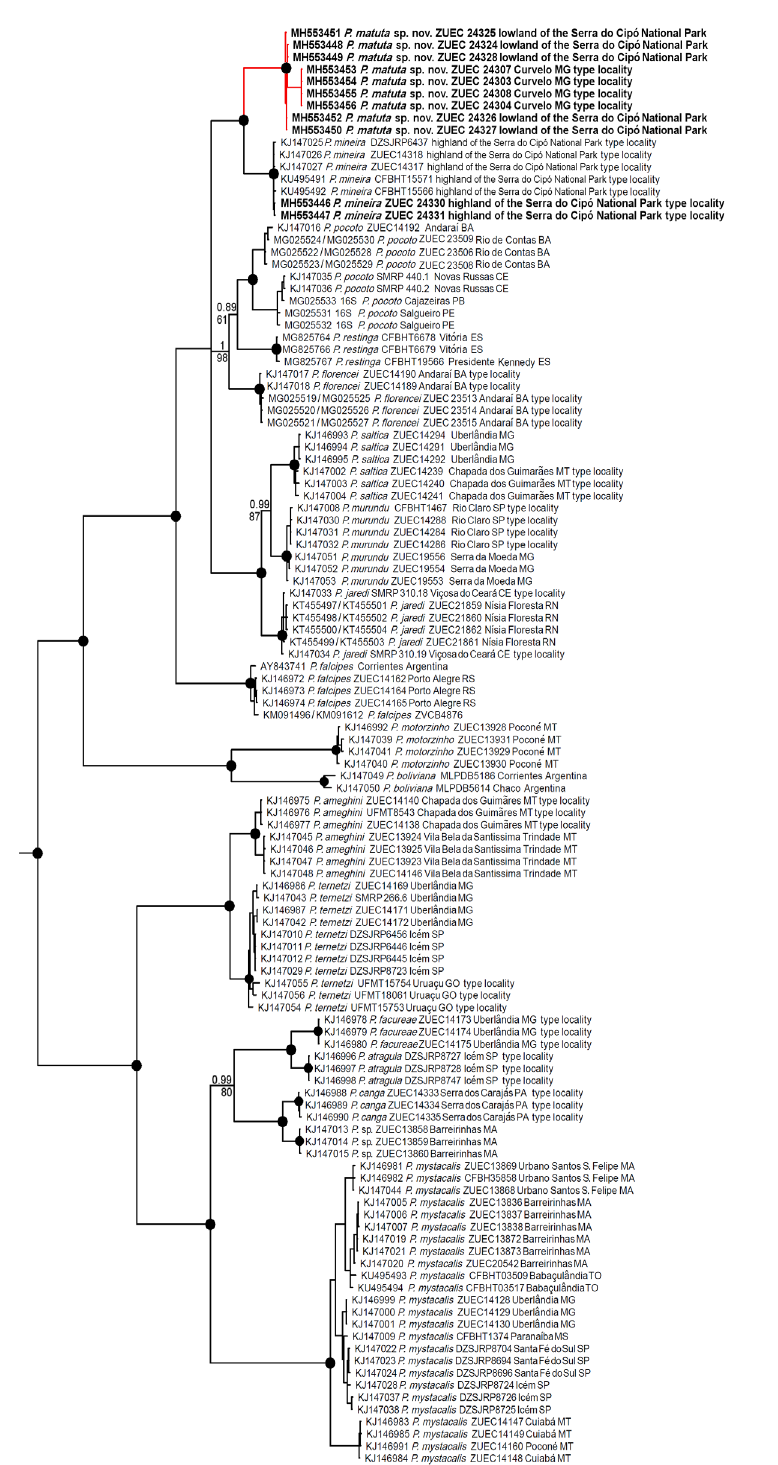
Fig. 6. 50% majority rule consensus tree based on the 12S and 16S rDNA mitochondrial genes of the species of Pseudopaludicola from Bayesian inference analysis. Numbers above branches are posterior probabilities (PP) and numbers below branches are the support values from a maximum likelihood bootstrap analysis. Black dots represent PP = 1 and bootstrap = 100; no support below species level is